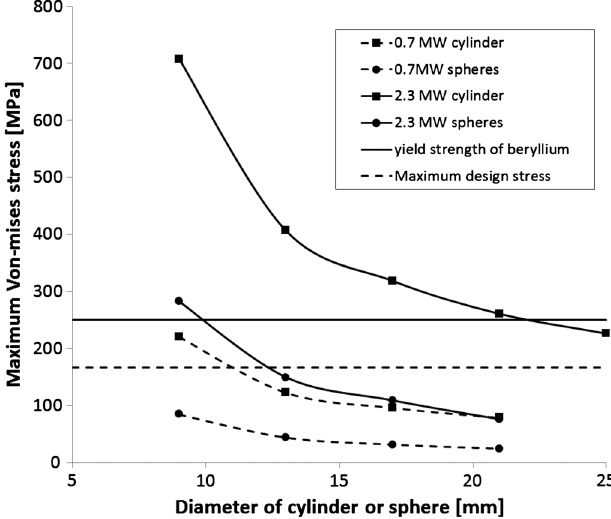
FIG. 5. Maximum Von Mises stress (including thermal and inertial components) across studied parameter space with a 2 σ off-center beam (worst case design point as seen in Fig. 1).